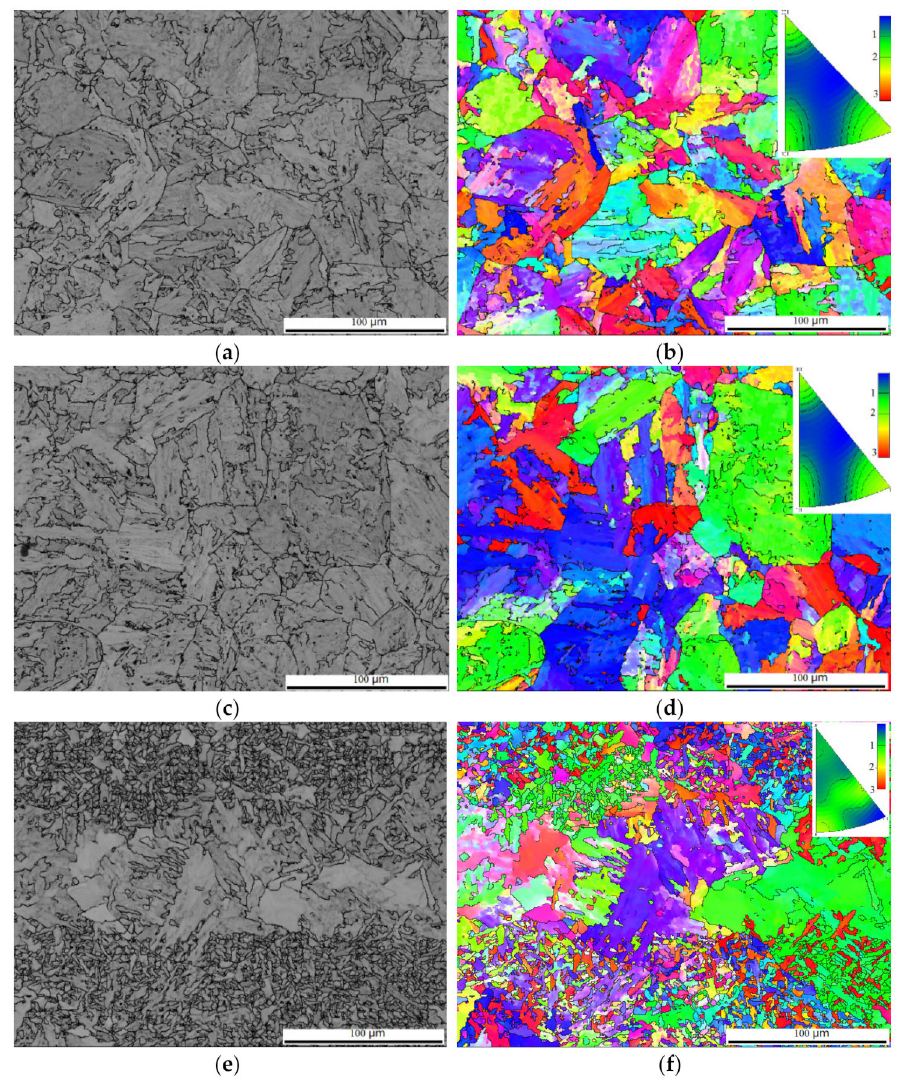
Figure 3. Image quality and orientation image of ( a , b ) the as-welded; ( c , d ) the typical; and ( e , f ) the spotty cases,